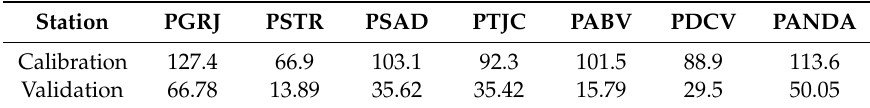
Table 1. Total rainfall in millimeters measured in 24 hours on the events selected for calibration and validation of the mathematical